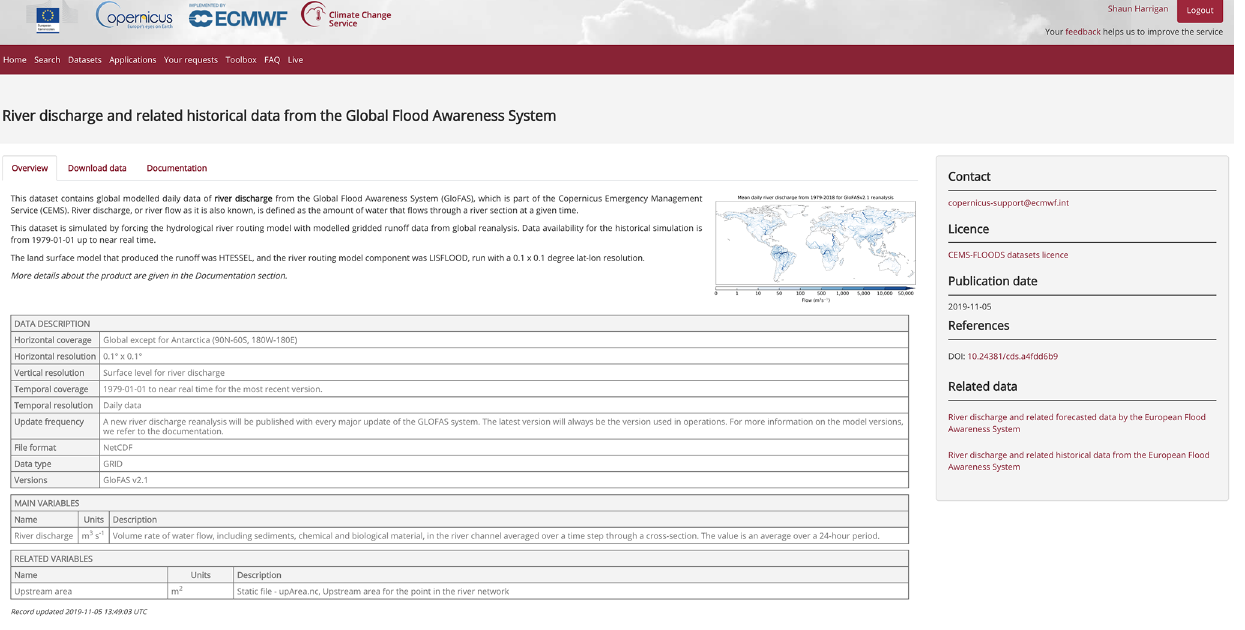
Figure 11. The GloFAS-ERA5 river discharge reanalysis landing page in the C3S Climate Data Store (CDS; https://cds.climate.copernicus.